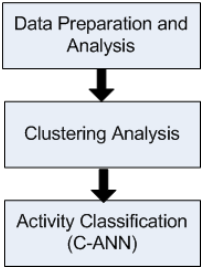
Figure 2. Major Steps.